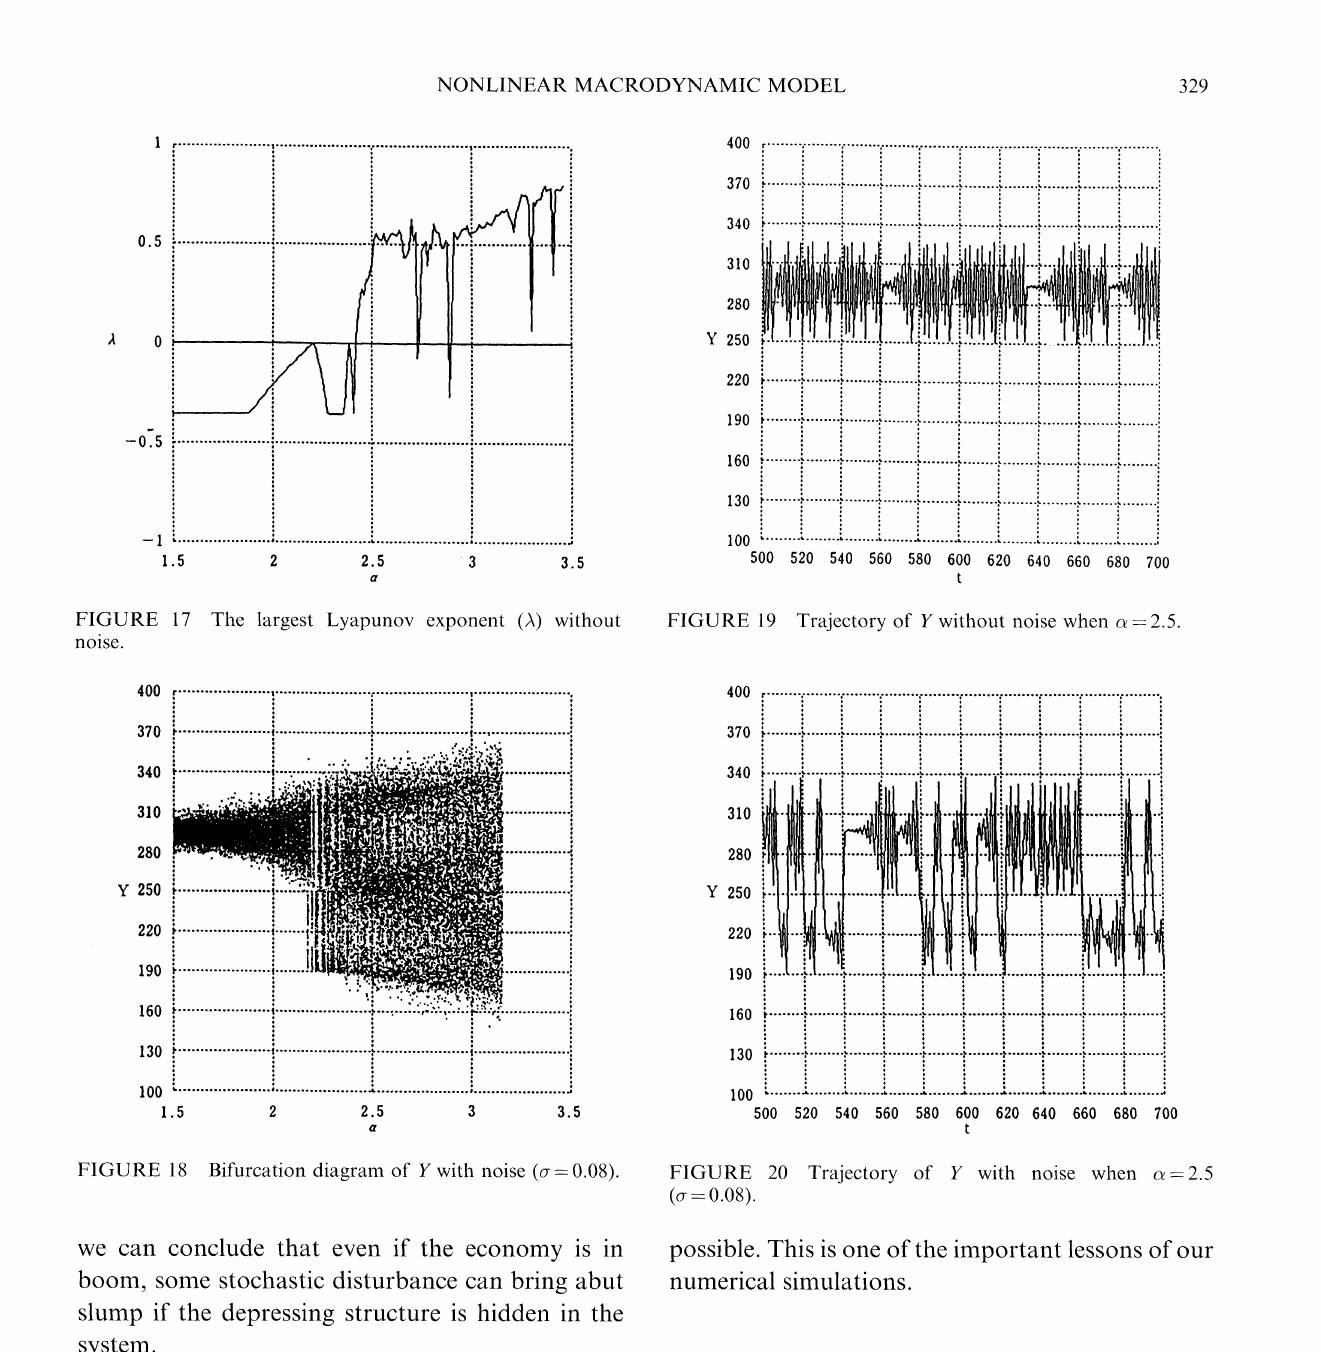
FIGURE 19 Trajectory of Y without noise when c= 2.5.